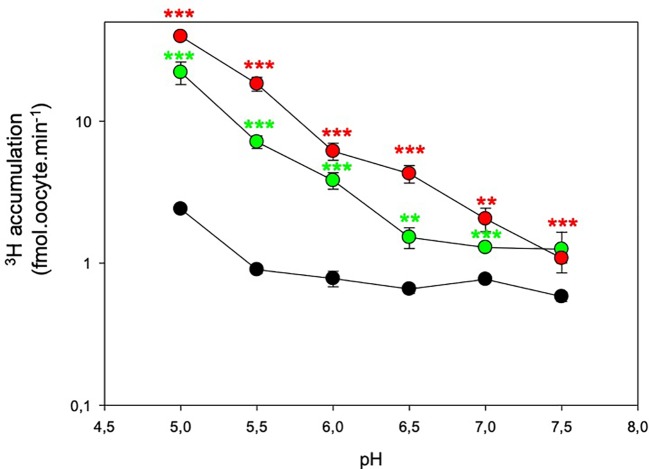
pH-dependent 3H accumulation in NPF4.5 and NPF4.6 in Xenopus oocytes. Control (noninjected, black circles), NPF4.5 (green circles) and NPF4.6 (red circles) injected oocytes were bathed in 1 μM 3H-ABA (pH = 5.0 to 7.5), and 3H accumulation in oocytes was quantified after 20 min. Values are mean +/− SEM (n = 6–20 oocytes, biological replicates). ***P < 0.001, **0.001 < P < 0.005, two-sided t-test after comparison with control oocytes.